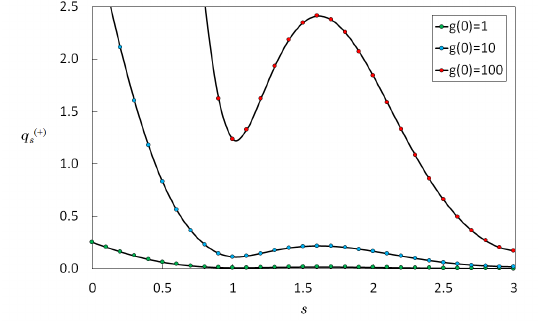
Figure 5. Dependence of the variational functions q w = 200. For both plots g ( 0 ) = 100.